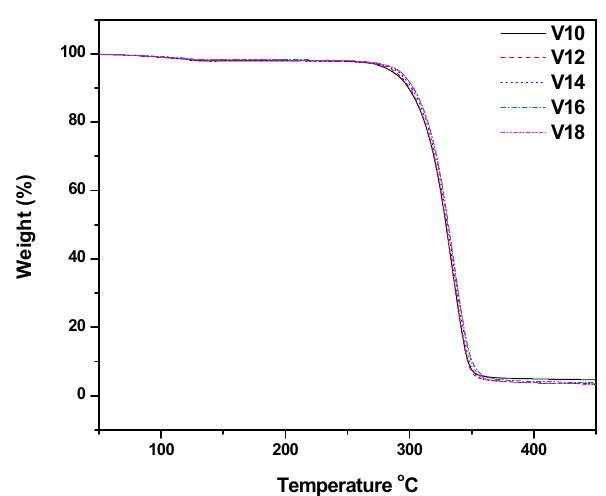
Figure 8. TGA thermograms of V10–V18 obtained a heating rate of 10 ° C/min in nitrogen.